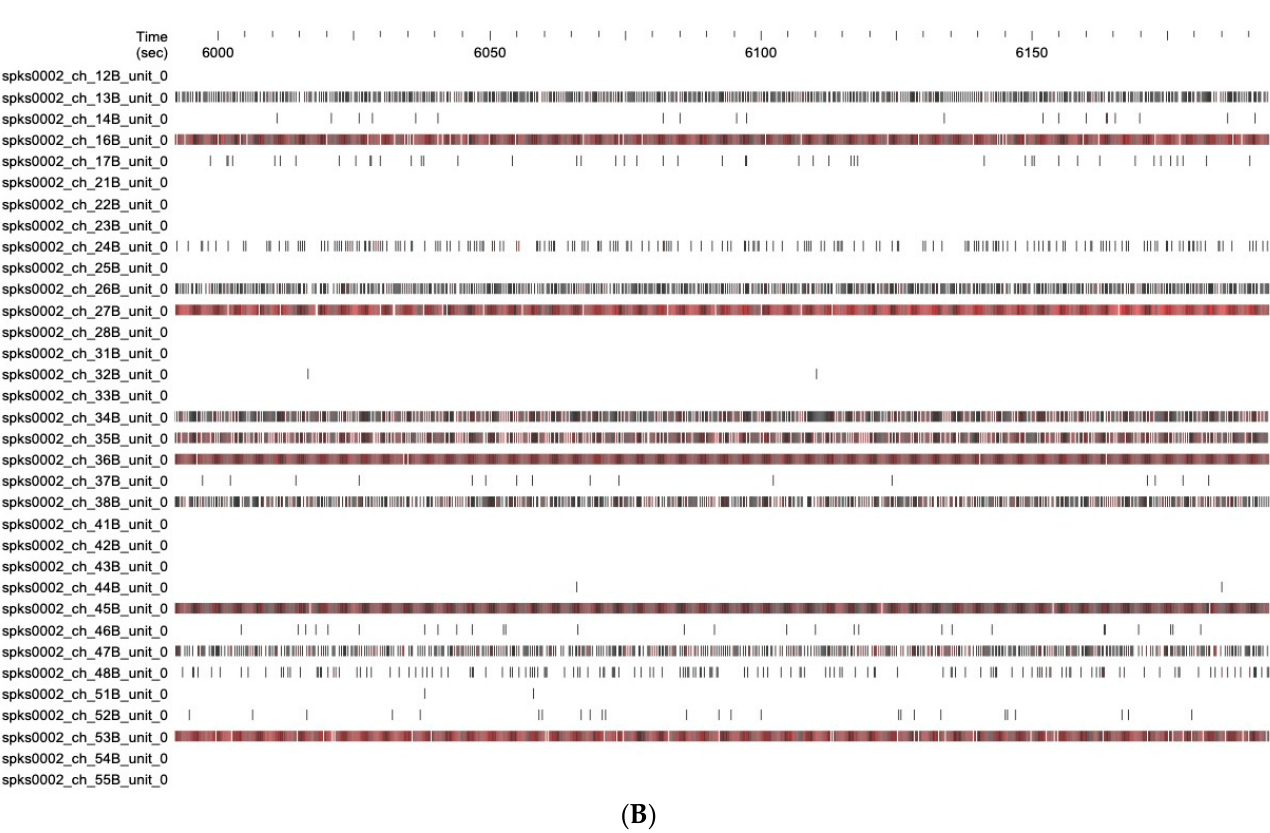
Figure A1. MEA recording raster plots of the spike times of 34 representative channels in the absence ( A ) or in the presence ( B ) of 50 µg/mL EO, in a time window of 200 s.